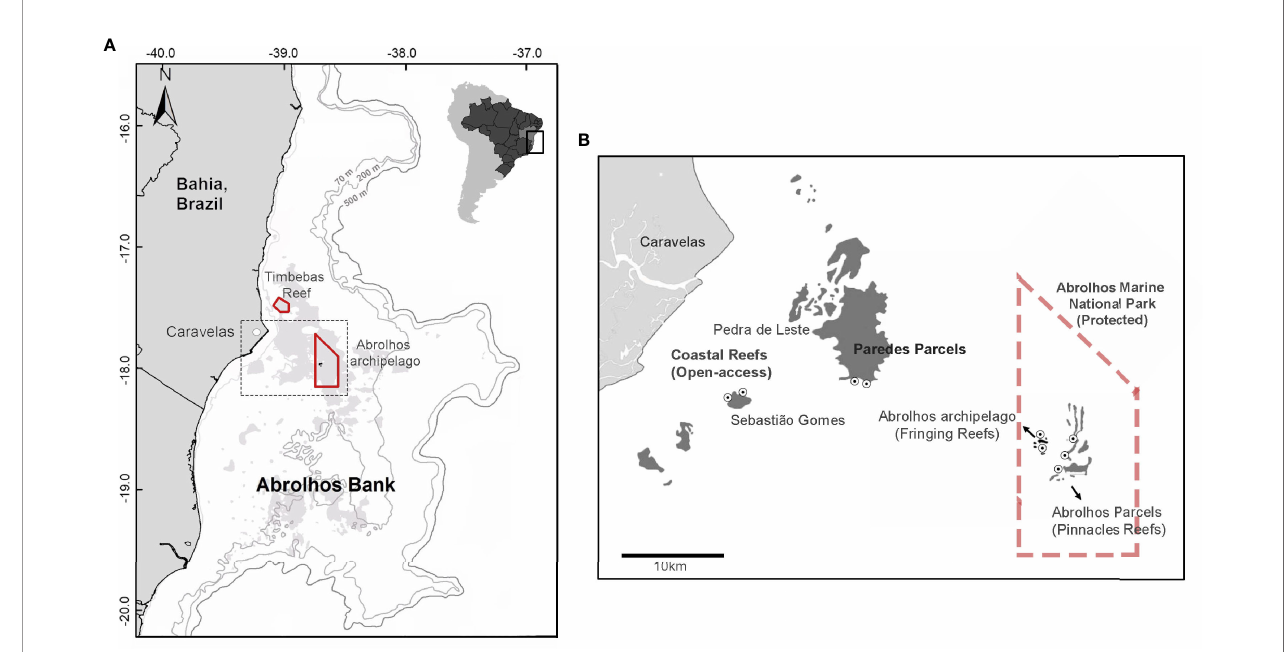
FIGURE 1 | The study area (dotted rectangle) within the Abrolhos bank with the bathymetry data, highlighting the Abrolhos Marine National Park (no-take marine reserve) in red (north portion — Timbebas; south portion — Abrolhos archipelago) and the reef area (shallow and mesophotic) in light gray (A) . The study area in detail with the shallow submerged coral reefs in dark gray and with the sample sites inside (Pinnacles and Fringing Reefs — Protected) and outside the no-take reserve (Coastal Reefs — Open Access) (black and white dots) (B) . More information on Supplementary Material ( Supplementary Figure S1 and Supplementary Table S1